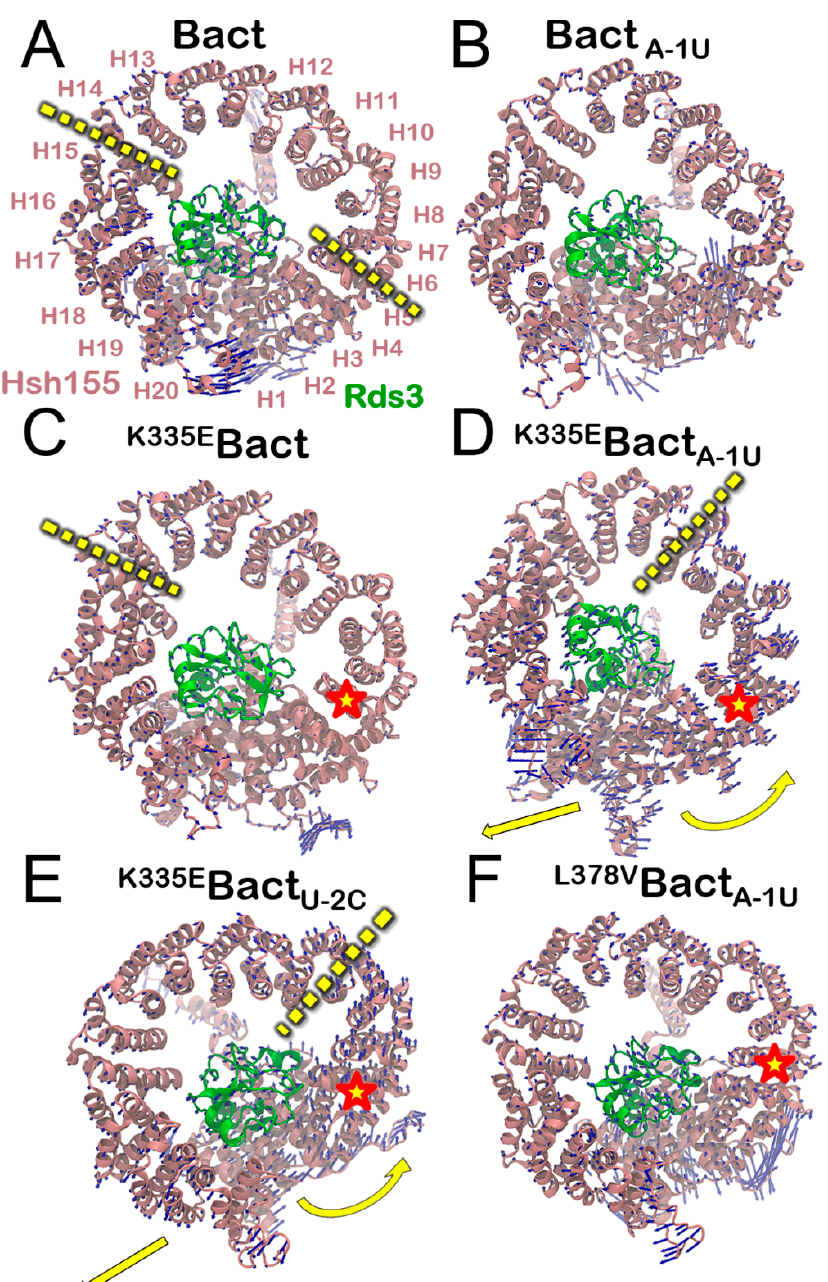
Figure 5. Essential dynamics as revealed by principal component analysis (PCA) for the Hsh155 protein in the ( A ) Bact , ( B ) Bact A-1U , ( C ) K335E Bact , and ( D ) K335E Bact A-1U ( E ) K335E Bact U-2C , and ( F ) L378V Bact A-1U models. ( A ) SF3b complex with labelled HEAT (huntingtin elongation factor 3 protein phosphatase 2A, target of rapamycin 1) -repeats of Hsh155 (pink), and Rds3 protein (green). The site of mutation is marked with a red star. Blue arrows show the motion of C α atoms along the first eigenvector. Yellow dashed arrows highlight the hinges present in Bact, K335E Bact A-1U , and K335E Bact U-2C models, and curved arrows highlight distinctive directions of motions in K335E Bact A-1U and K335E Bact U-2C models.